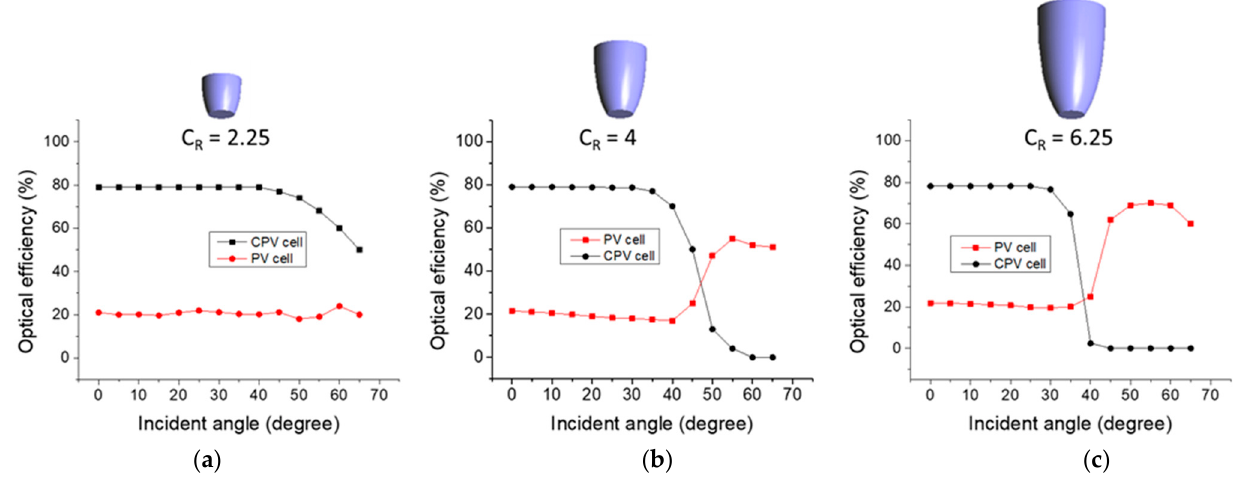
Table 1. Main parameters of the static CPV module.